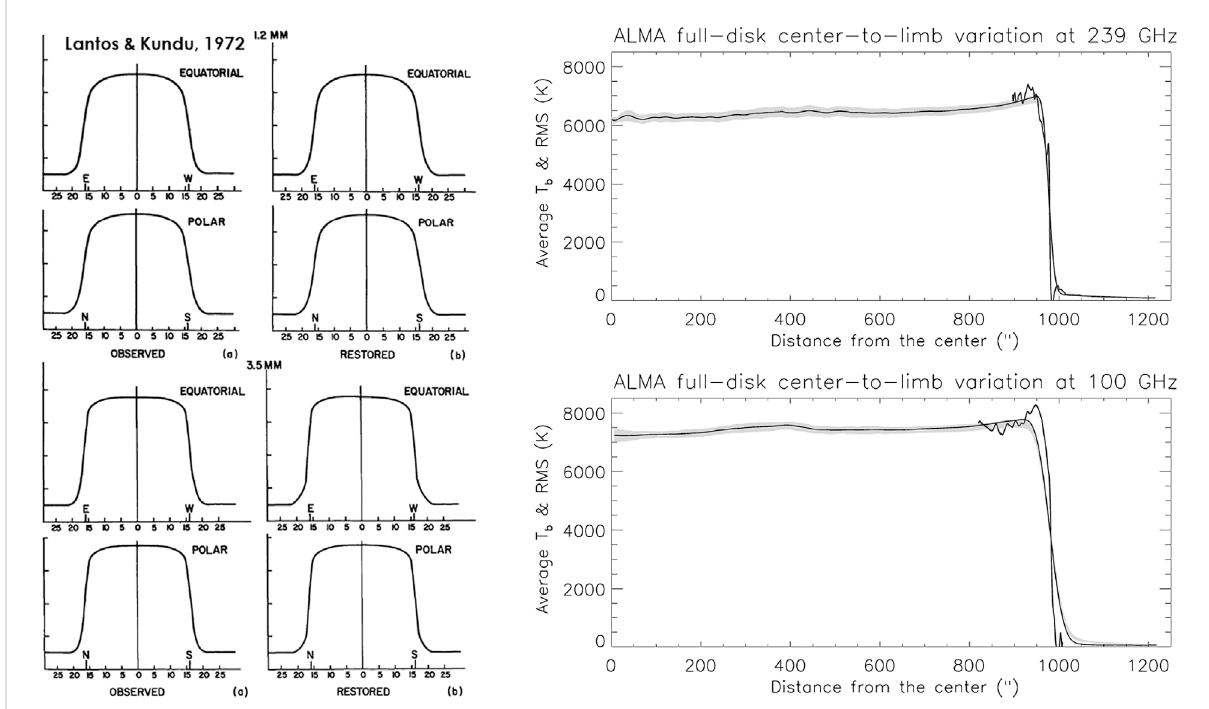
FIGURE 8 Old and new Center-to-limb variation (CLV) curves). Left: CLV curves at 1.2 and 3 mm (250 and 100 GHz respectively) from Lantos and Kundu (1972). Reproduced with permission ⓒ ESO. Right: CLV curves for 239 and 100 GHz form ALMA full-disk images from Alissandrakis et al. (2017). The gray band shows the measured values ± the corresponding rms. The superposed blue curves near the limb are from high resolution ALMA images. Curves in black show the CLV after correction for diffuse light. Reproduced with permission ⓒ